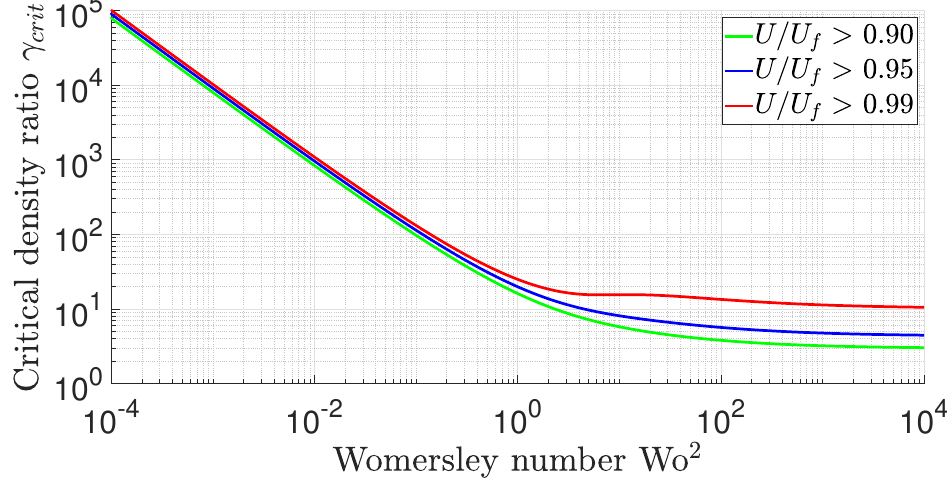
Figure 4. Critical density ratio γ crit depending on the Womersley number Wo 2 for cut off criteria of U / U f > 90%, U / U f > 95%, and U / U f > 99%. Above the respected line, the particle motion is not affected by the flow and the slip velocity can be set equal to the fluid velocity (no relaxation